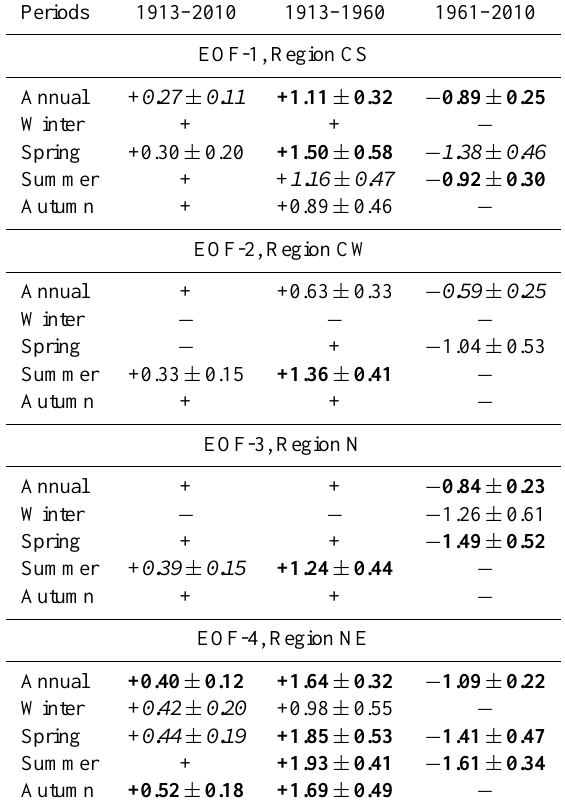
Table 4. As in Table 3, but for the mean series of the four regions defined in